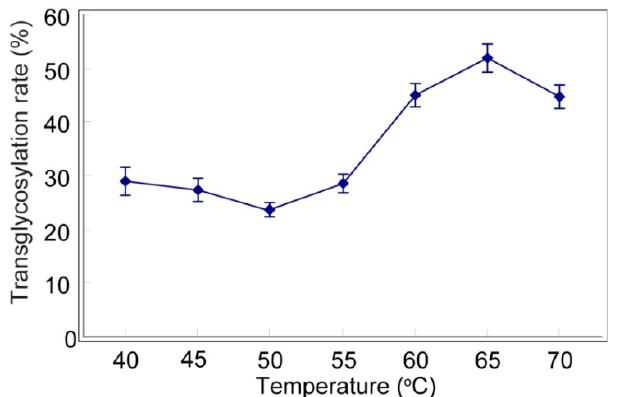
Figure 2. Transglycosylation rate affected by temperature.